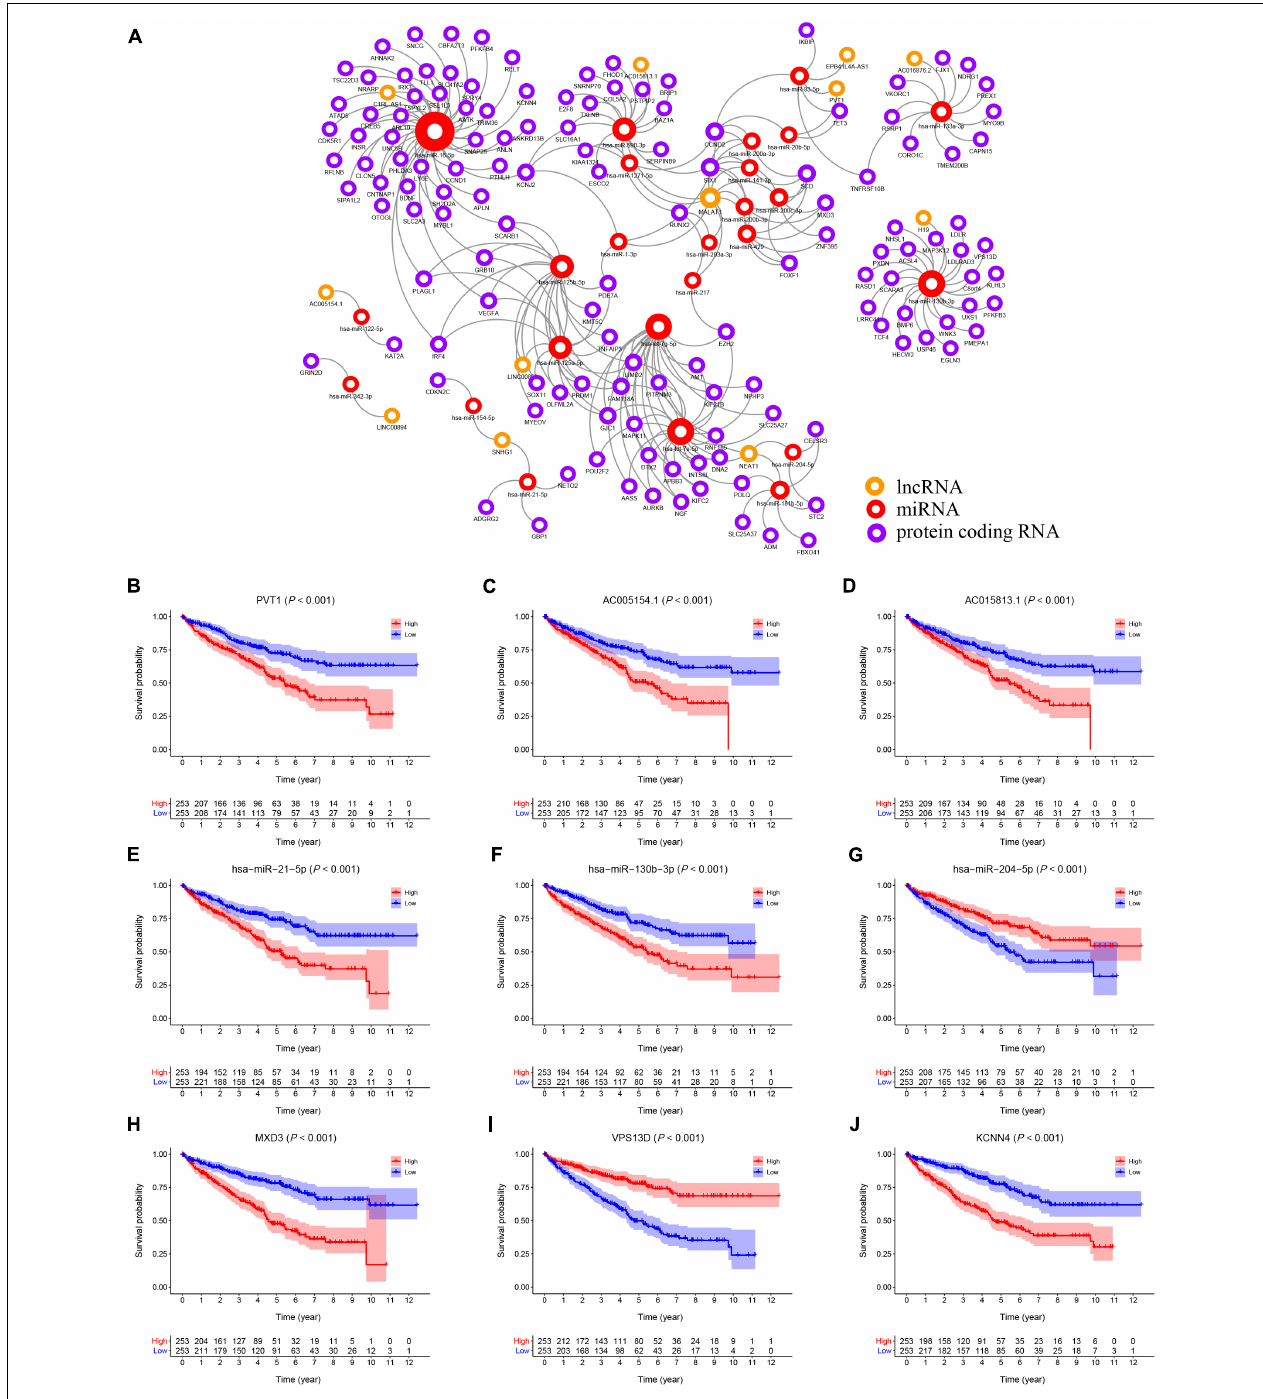
FIGURE 3 | (A) The KIRC related ceRNA network consisting of 12 lncRNAs, 25 miRNAs and 136 mRNAs. (B–J) The K–M survival curves of the top three lncRNAs, miRNAs, and mRNAs: PVT1 (B) , AC005154.1 (C) , AC015813.1 (D) , hsa-miR-21-5p (E) , hsa-miR-130b-3p (F) , hsa-miR-204-5p (G) , MXD3 (H) , VPS13D (I) , and KCNN4 (J)